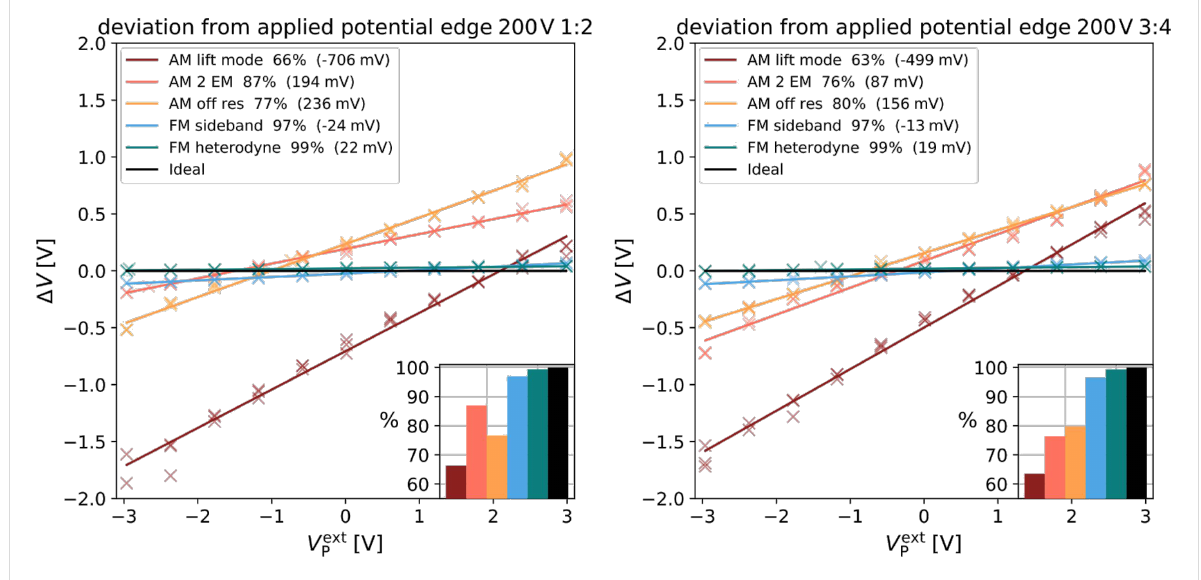
Figure 6: Comparison of the deviation of the measured potential difference from the applied potential plotted against the applied potential for AM (warm colors) and FM (cool colors), black represents an ideal measurement. Insert in the lower right visualizes the fraction of the potential captured by the respective method. Legend in the upper left shows the offset in brackets. Data shown captured on the electrodes 1/2 (left) and 3/4 (right) of the electrode structure with an additional electrostatic